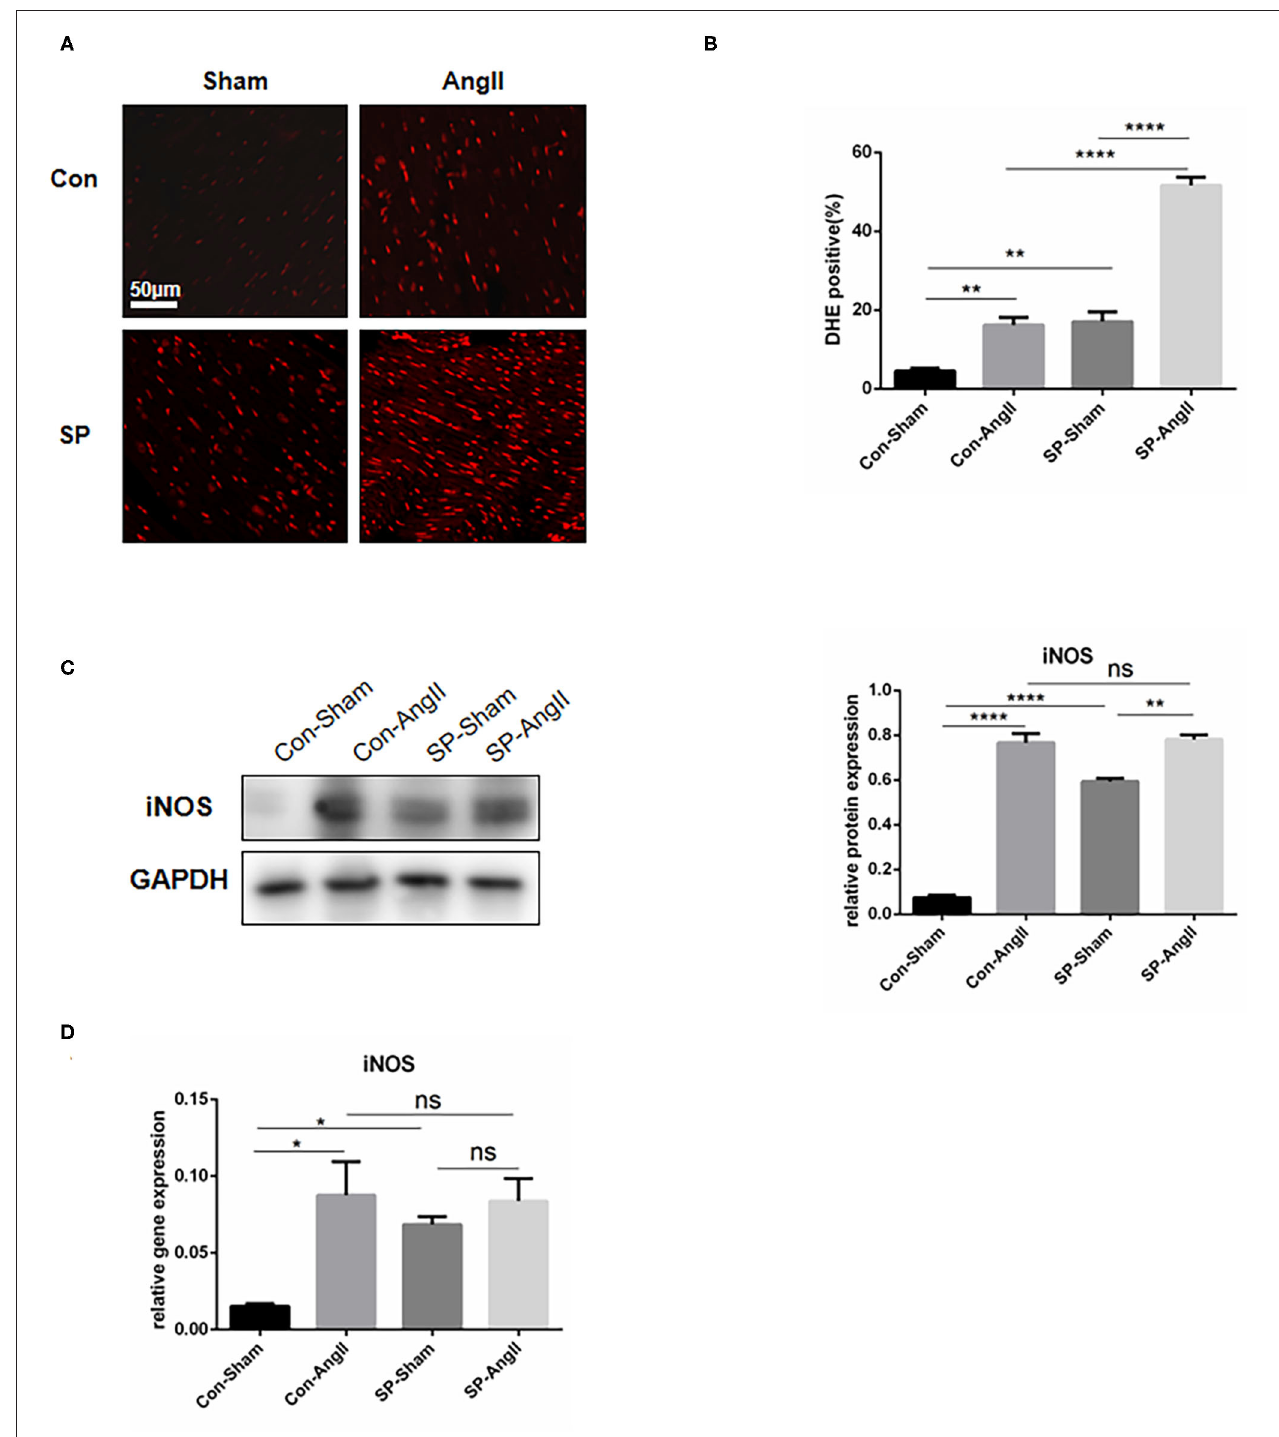
FIGURE 3 | Cardiac fibroblast-specific PGC-1 α KO activates the oxidative stress response in the heart. (A) Representative cross sections of the heart stained for DHE. (B) Quantitative analysis of reactive oxidative stress as assessed by DHE staining. (C) Representative Western blot and analysis of the expression of iNOS. (D) qPCR analysis of the mRNA expression levels of iNOS . N.S. indicates no significant difference. * p < 0.05, ** p < 0.01. Data represent mean ± SEM ( n = 3–5 per group).